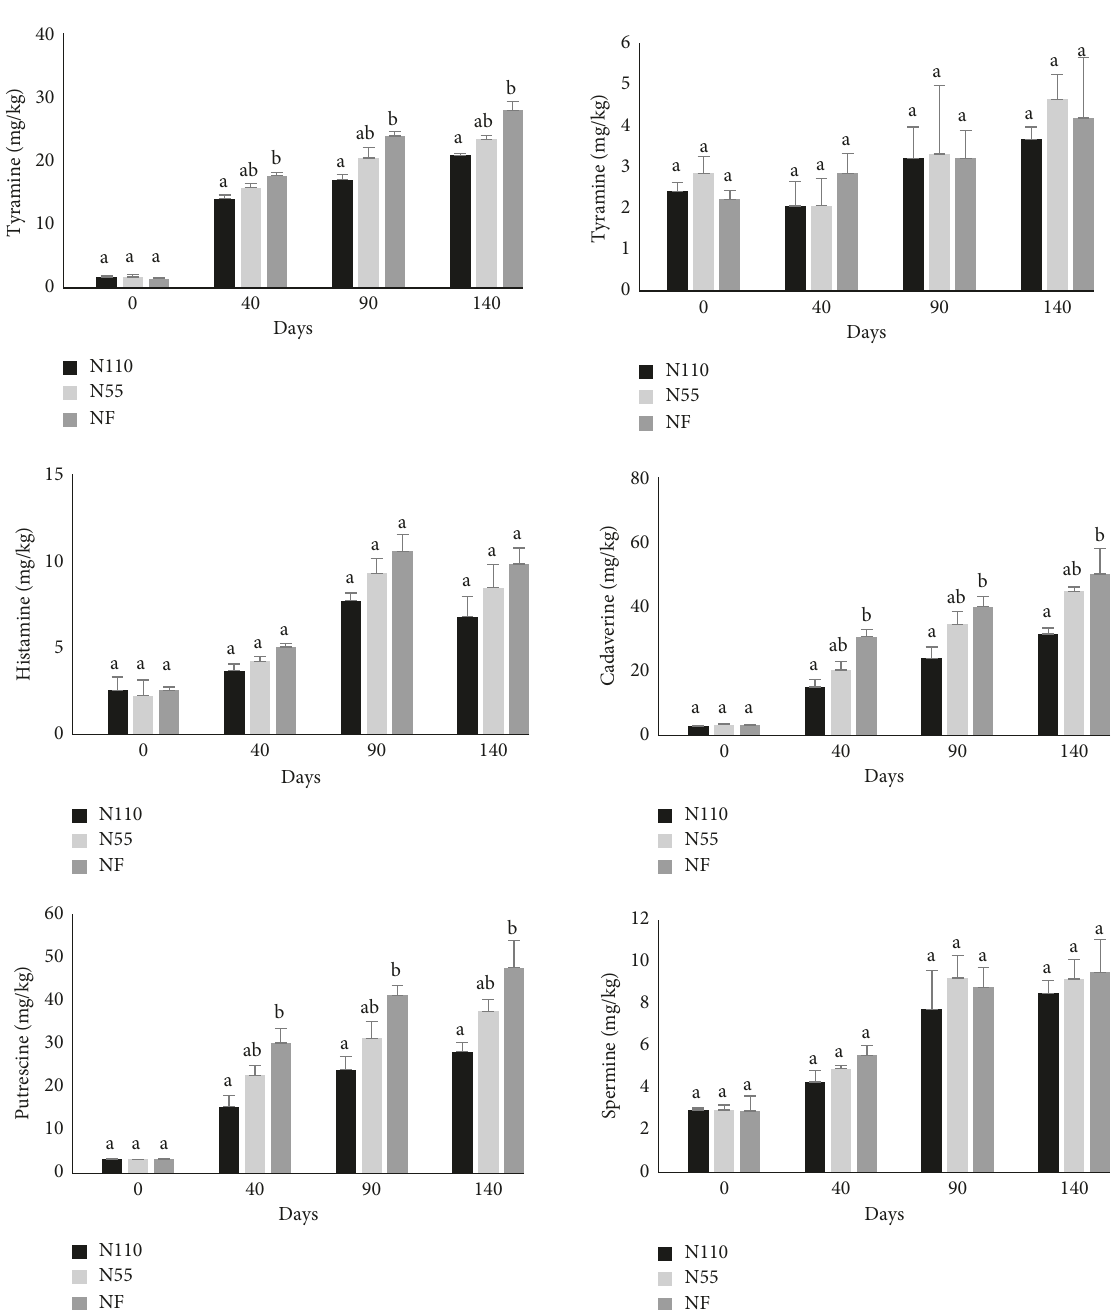
Figure 2: Changes in levels (mg/kg d ) of tyramine, tryptamine, histamine, cadaverine, putrescine, and spermine in kulen affected by sodium nitrite level during ripening and storage (mean ± standard deviation). Values followed by different letters (a–b) differ significantly ( P < 0 . 01). d Fresh sample